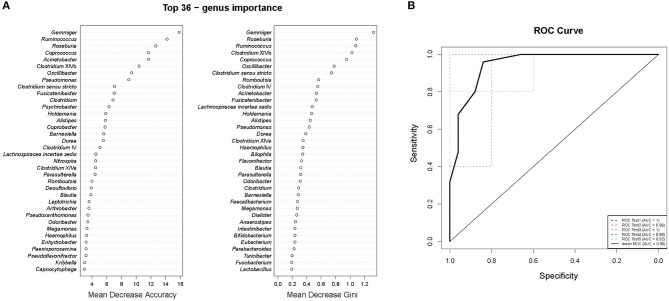
Gut microbiota (GM) biomarkers for classifying ICPP patients from healthy girls. (A) Mean Decrease Accuracy and Mean Decrease Gini of attributes as assigned by the random forest. (B) The accuracy of candidate GM biomarkers was verified with cross-validation. The AUC value was calculated and receiver operating characteristic curves (ROC) were drawn with five repeats.